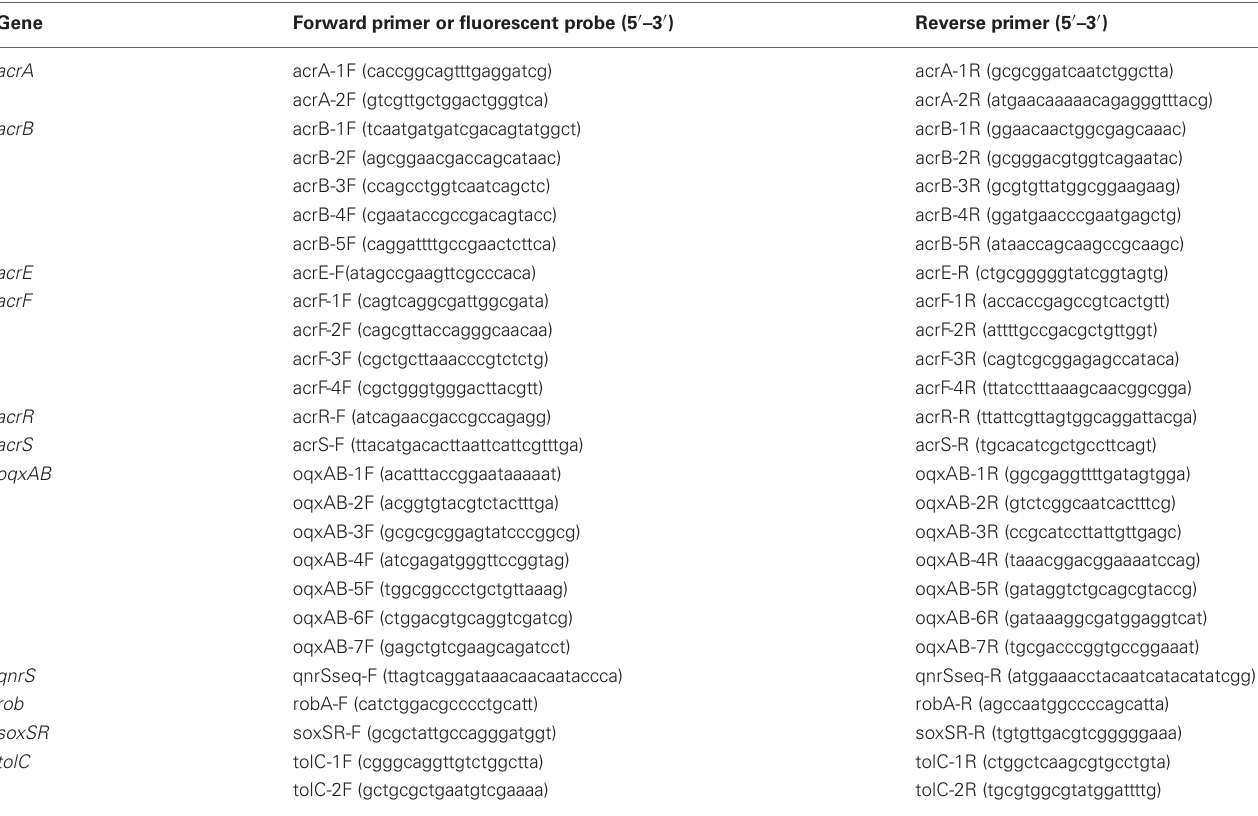
Table 1 | Sequences of primers used for PCR and DNA sequencing in this study.